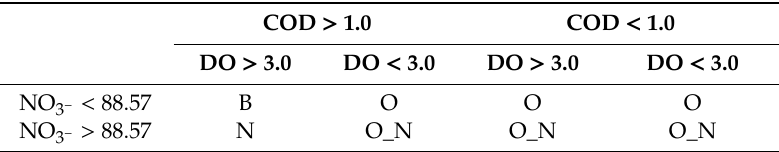
Table 1. Grouping rules of di ff erent pollutant type (unit: mg /